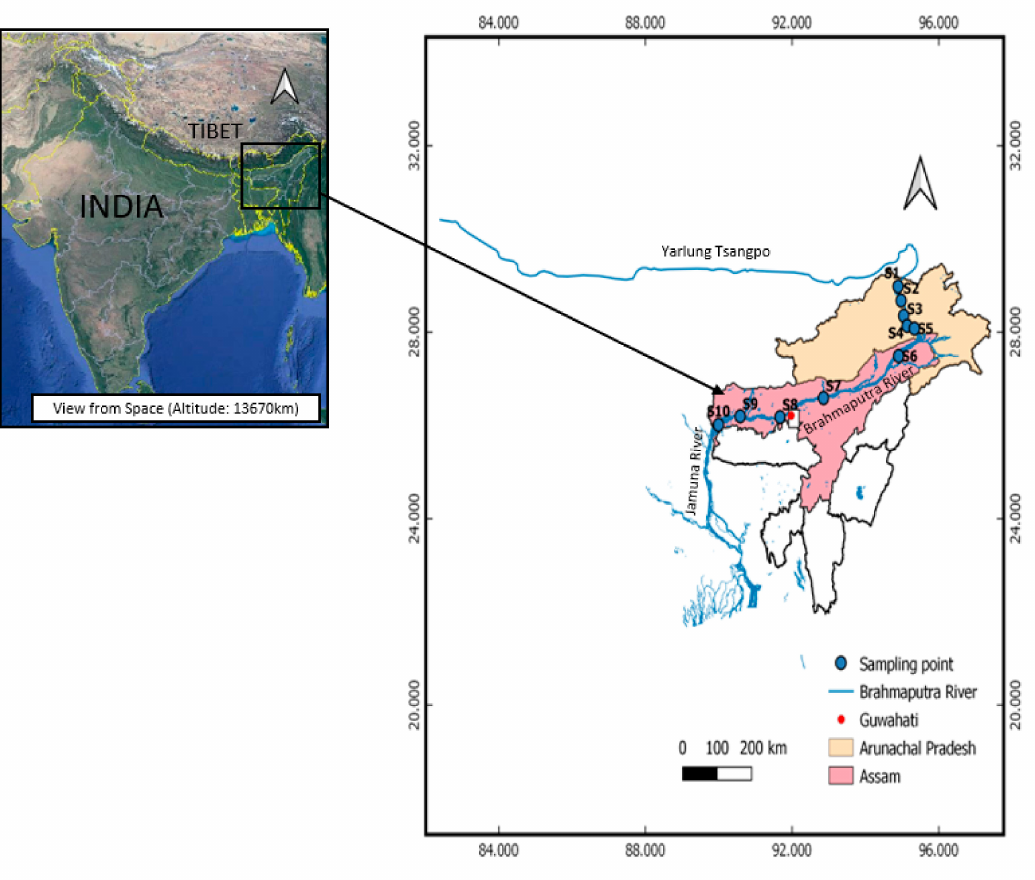
Figure 1. Sampling sites of the Brahmaputra River in Arrunachal Pradesh (S1–S5) and Assam (S6–S10), India (map drawn from Google Earth Pro and using QGIS 3.12 mapping